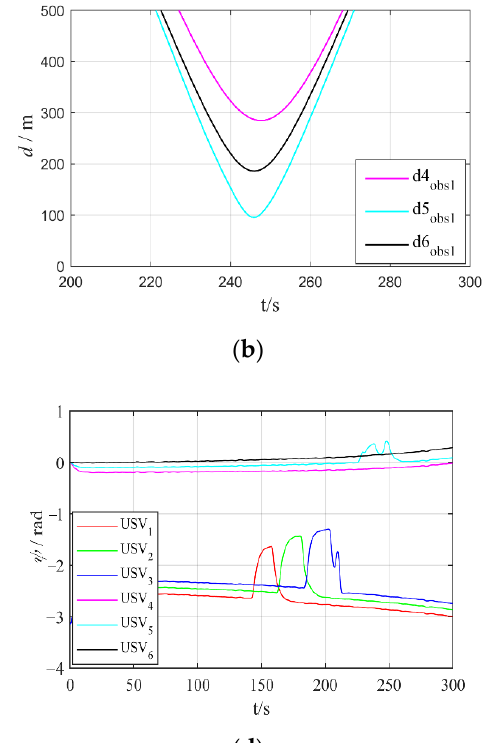
Figure 8. Pursuit − evasion simulations with dynamic obstacle ships. ( a ) t = 300 s; ( b ) t = 600 s.